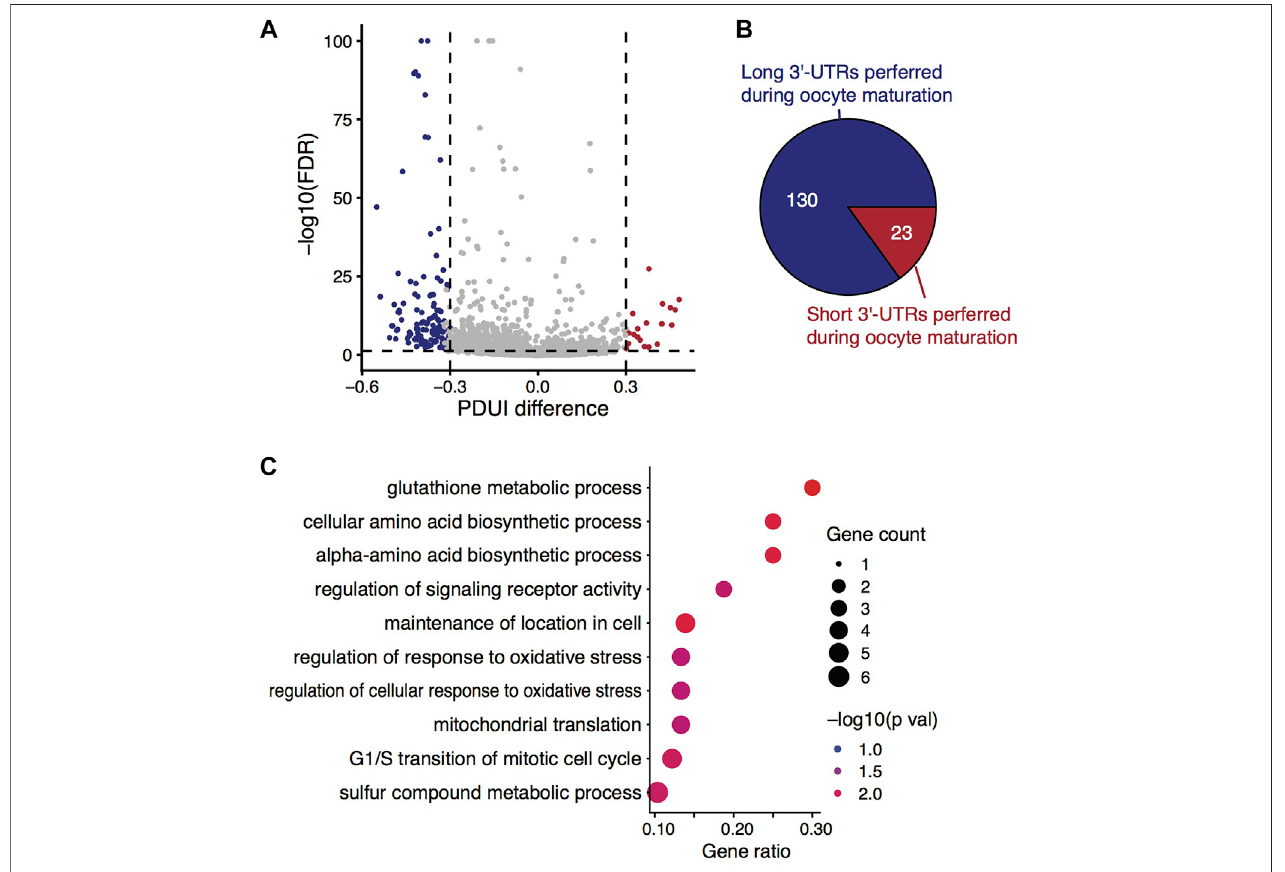
FIGURE 3 | Alternative 3 ′ -UTR isoform switches during mouse oocyte maturation. (A) Volcano plot showing the differences in percentage of distal poly(A) site usageindex(PDUI)betweenisoformpairsagainsttheassociatedstatisticalsigni fi cancelevel(FDR). (B) Piechartdemonstratingtheasymmetric3 ′ -UTRisoformswitches towards longer UTRs along with oocyte maturation. (C) GO term enrichment analysis of genes exhibiting signi fi cantly alternative usage of 3 ′ -UTR isoforms during the oocyte maturation.